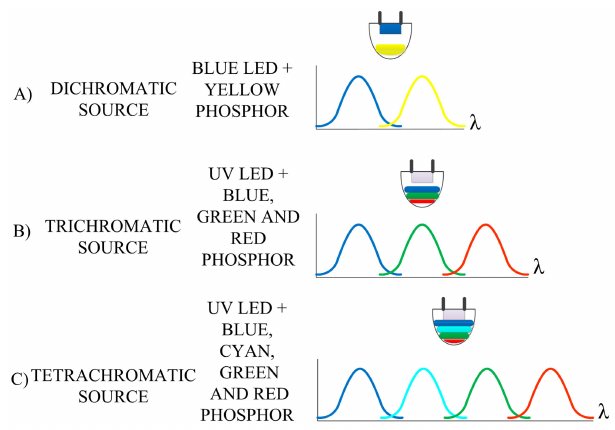
Figure 1. Selected types of white light sources based on wave